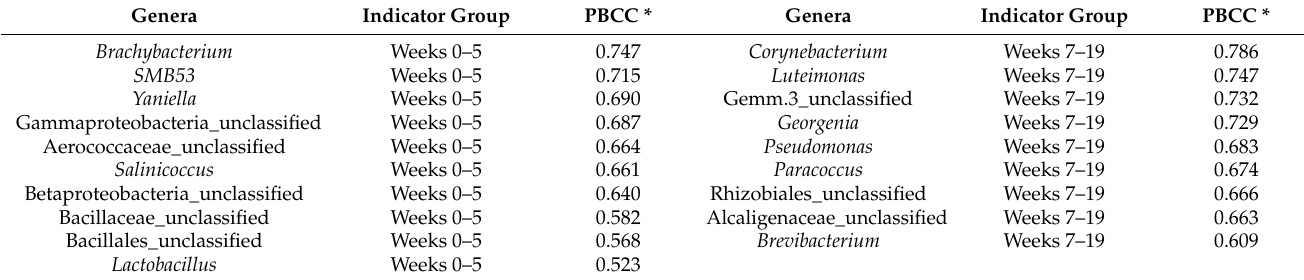
Table 4. Indicator species for Spent Beetle sampled while piled in pastureland. Samples were group in Weeks 0–5 and Weeks 7–19 for comparisons. Only those genera whose relative abundances across all weeks were 0.05% or higher and had a p -value ≤ 0.01 and Point Biserial Correlation Coefficient (PBCC) * value ≥ 0.50 are shown. n = 1 composite